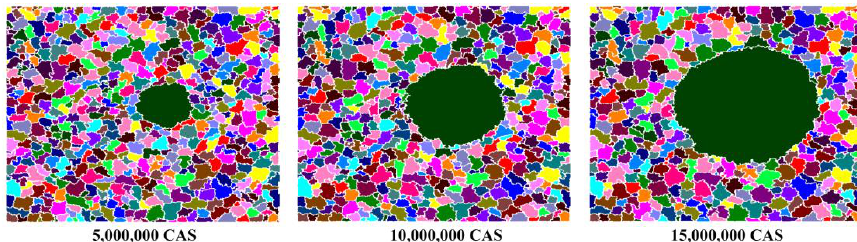
Figure 5. Microstructure evolution with a single abnormal grain at different CASs.